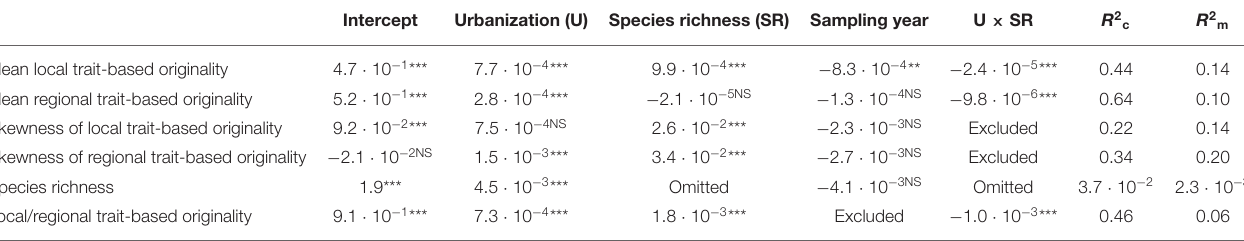
TABLE 2 | Results for the generalized linear mixed models (GLMM) that were run on the complete dataset (native + non-native species), including community level metrics (mean and skewness of local and regional functional originalities and species richness) and the species-specific ratio of functional local originality to regional